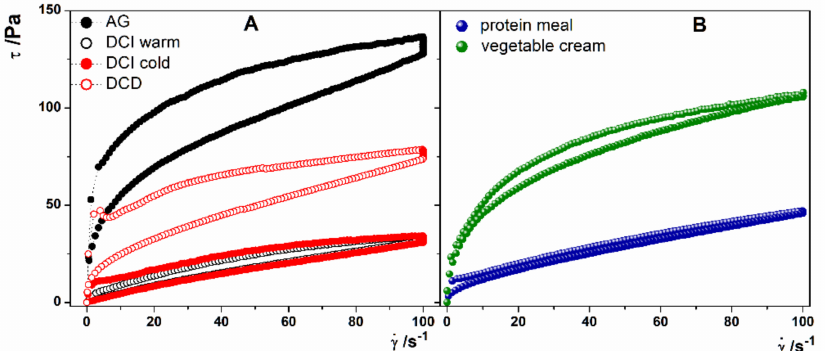
Figure 2. Thixotropy loop experiments of ( A ) AG (full black circles), DCI hydrated with warm water (open black circles), DCI hydrated with cold water (full red circles), DCD (open red circles), ( B ) Protein Meal (full blue circles) and Vegetable Cream (full green circles).